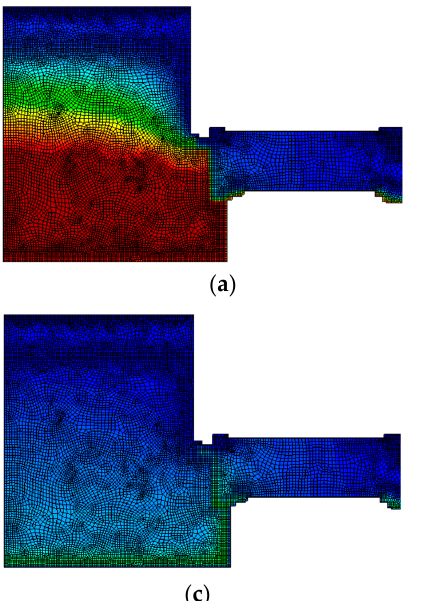
Figure 12. Relative humidity distribution (-) over the masonry and wooden beam end provided with interior thermal insulation made of mineral wool: ( a ) 9 January, 16:00, ( b ) 10 April, 22:00, ( c ) 11 July, 11:00, and ( d ) 10 October, 10:00. The relative humidity values were obtained using computational modeling technique described in Section 4.